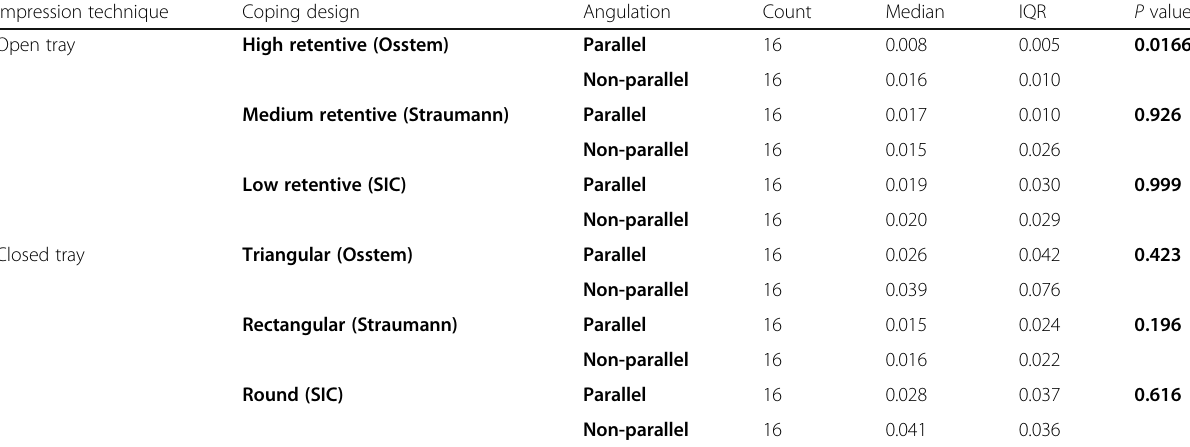
Table 4 Effect of impression coping design and implant angulation on accuracy Impression